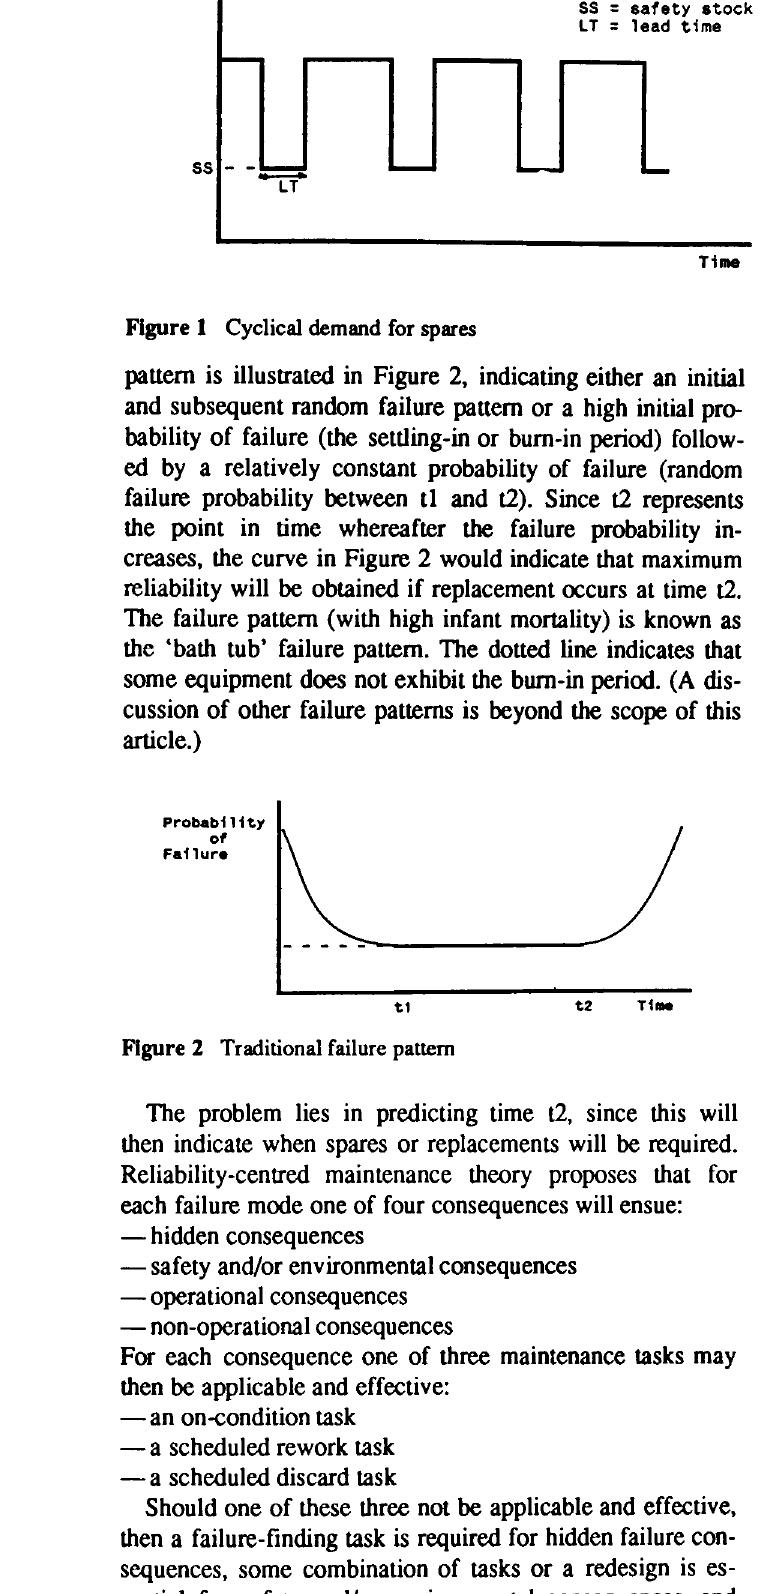
SS= safety stock LT= lead time